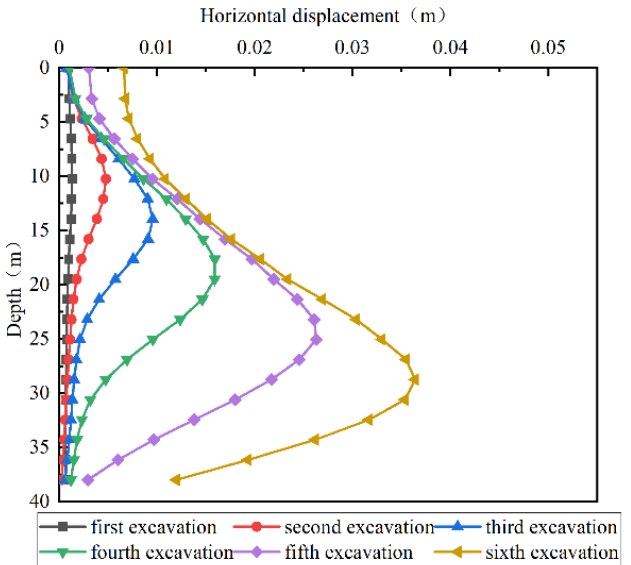
Figure 19. Horizontal displacement curve of foundation pit excavation enclosure structure with a seepage point at 0.01 m.